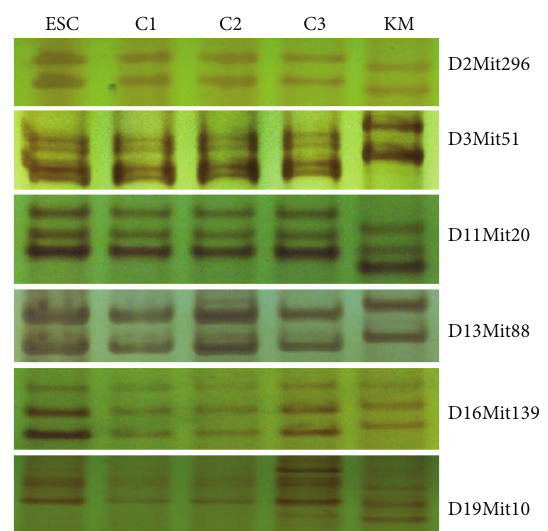
Figure 5: Microsatellite DNA analysis of fully ESC-derived mice. Microsatellite DNAs from cultured ESCs, three chimeric mice (C1, C2, and C3), and KM mouse recipient were amplified. Microsatellite loci D2Mit296, D3Mit51, D11Mit20, D13Mit88, D16Mit139, and D19Mit10 are